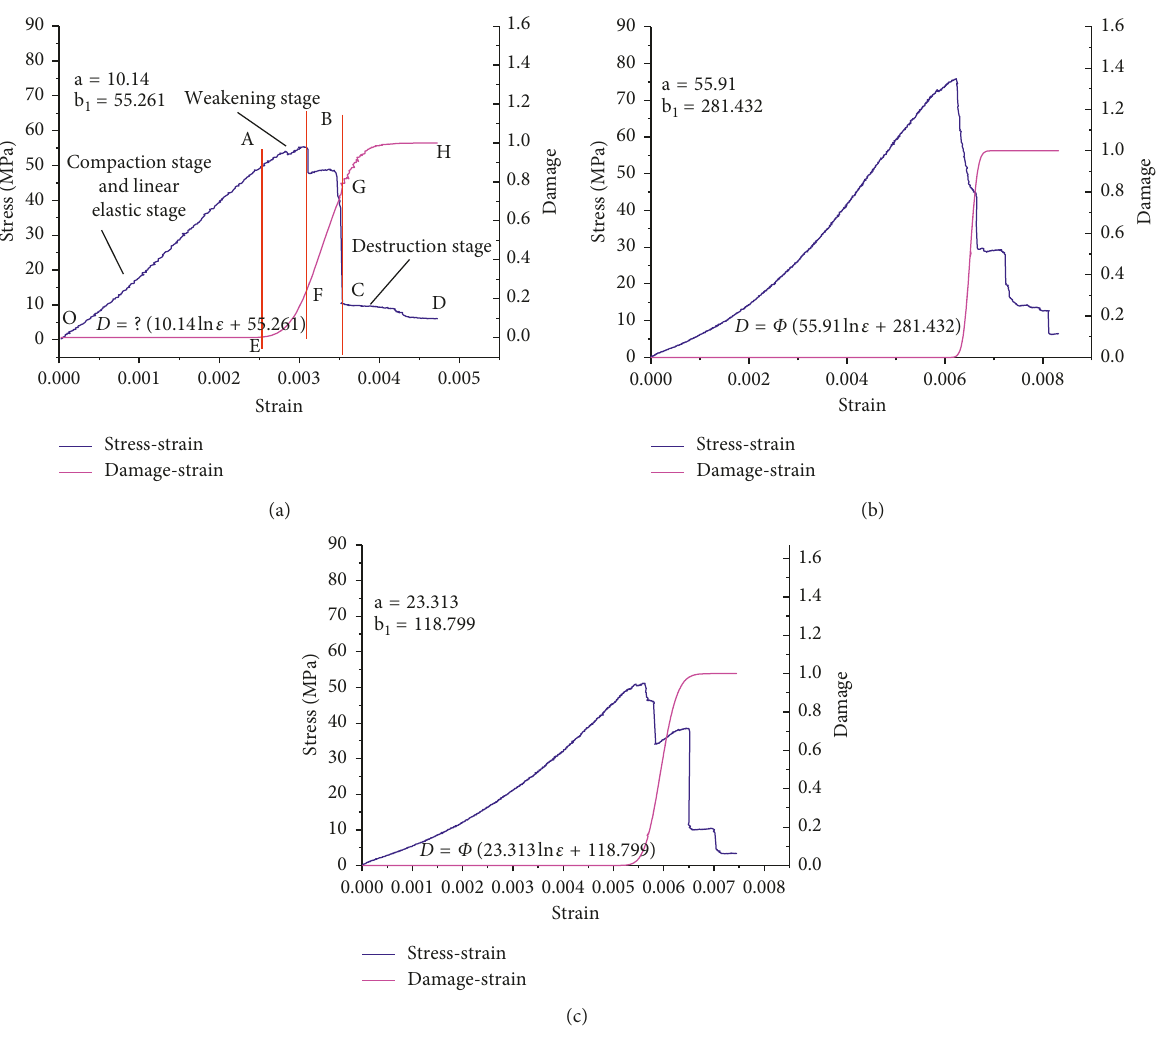
Figure 2: Evolution of damage variable. (a) Sample no. 1. (b) Sample no. 2. (c) Sample no. 3.